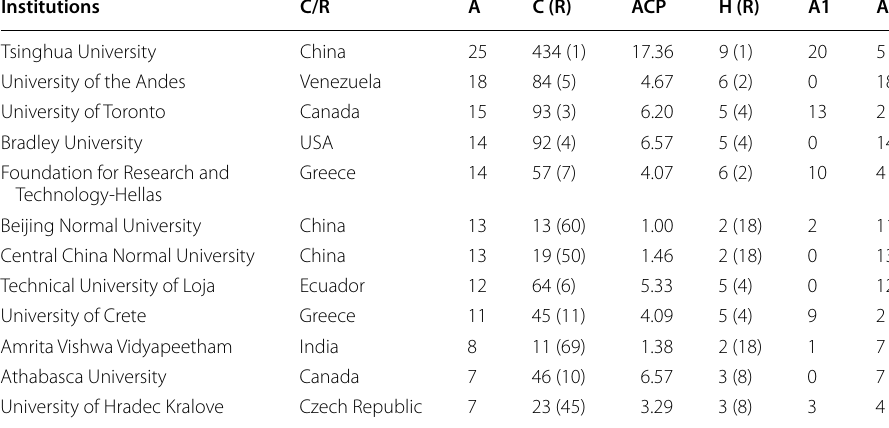
Table 4 Top prolific institutions